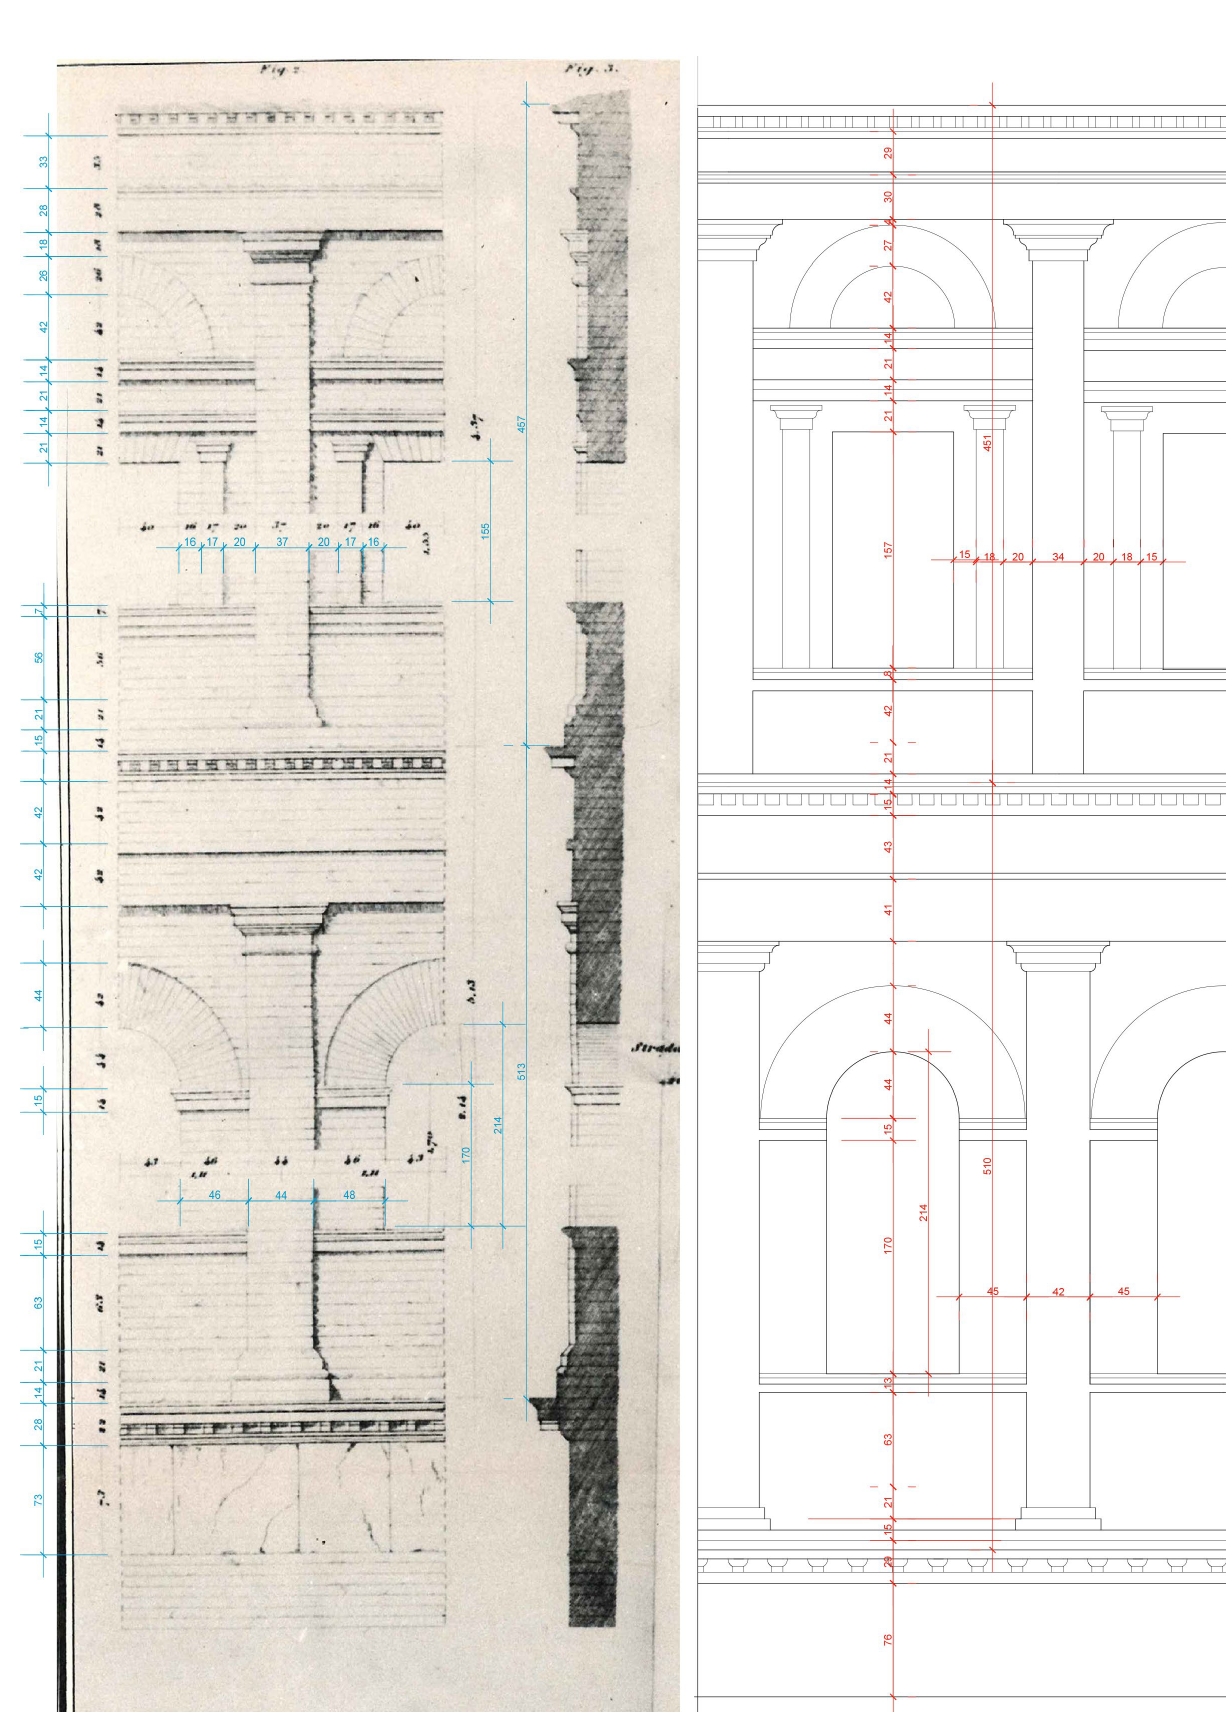
Figure 12 . Comparison between the elevations shown in the historical survey of Promis and the elevations deduced from the current survey. On the left: the detailed drawings of Promis (shown in Board I), in which the dimensions, difficult to read on the original, are rewritten in light-blue; on the right: excerpt of the survey elevation with the indication of the real dimension of the same elements measured by Promis. © M.